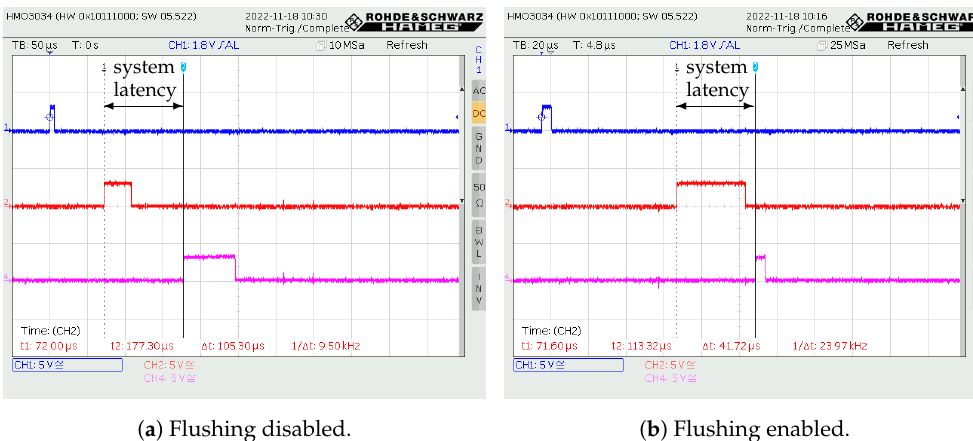
Figure 18. Measurement of time between the positive edge of the S_IN (middle) and the positive edge of the S_OUT (bottom) signal when flushing is ( a ) disabled and ( b ) enabled. This value is equal to the latency from the pre-processing block to the output of the early obstacle detection chain.